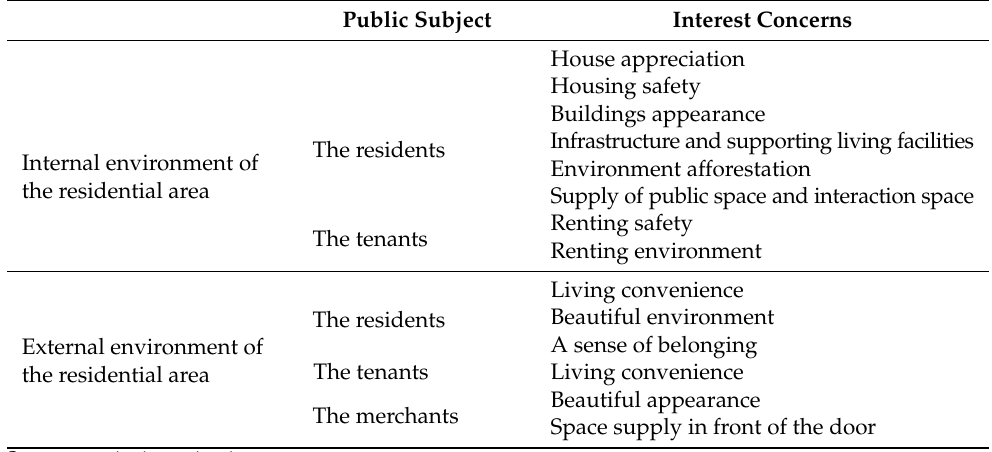
Figure 4. Location and layout of YFM Community. (Source: the authors). Table 1. The interest concerns of the public for community